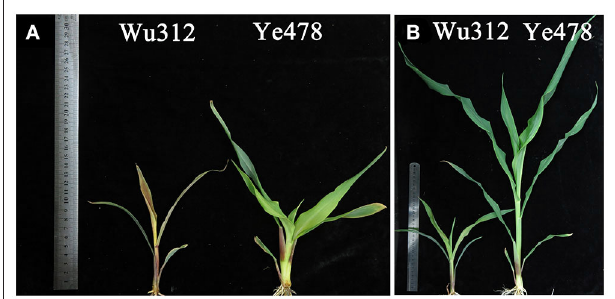
FIGURE 3 | Shoots of Zn-sensitive inbred line Wu312 (left) and Zn-tolerant inbred line Ye478 (right) under different Zn-deficient status at the 21th day after transfer in Experiment 2. (A) 0 µ M EDTA-Zn; (B) 0.5 µ M EDTA-Zn. A 30 cm-length ruler was shown in both (A,B)